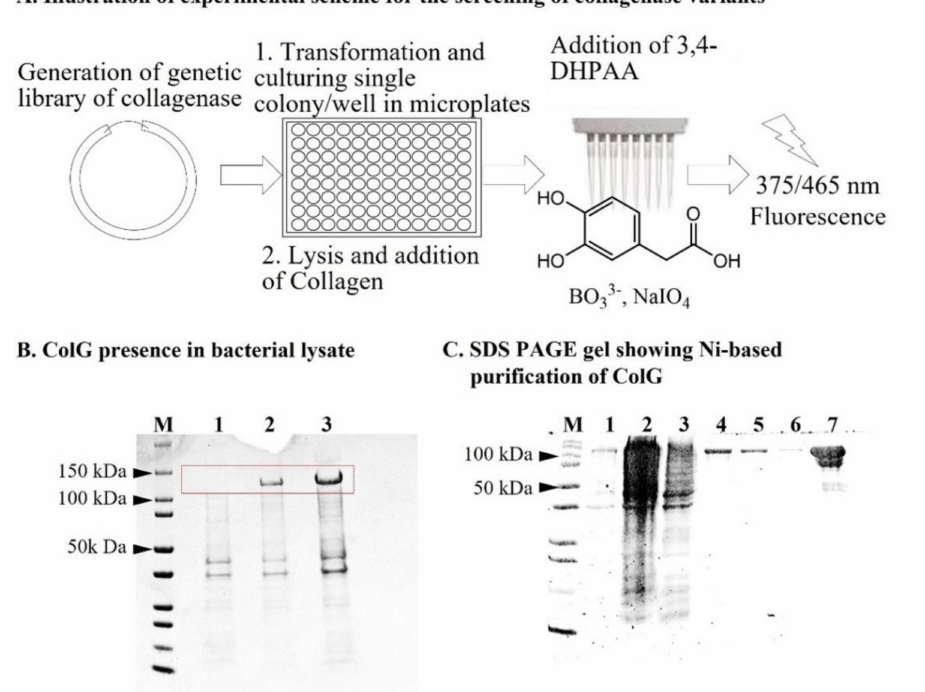
Figure 1. Illustration of activity assay and Coomassie-stained SDS–PAGE gels. ( A ) For screening of the genetic library of collagenase variants, single colonies were cultured in a 2 mL 96-well plate. Following lysis and separation of soluble fraction, activity was evaluated based on the 3,4-DHPAA assay. ( B ) The expression of ColG in E. coli BL21 cells before and following induction by IPTG.